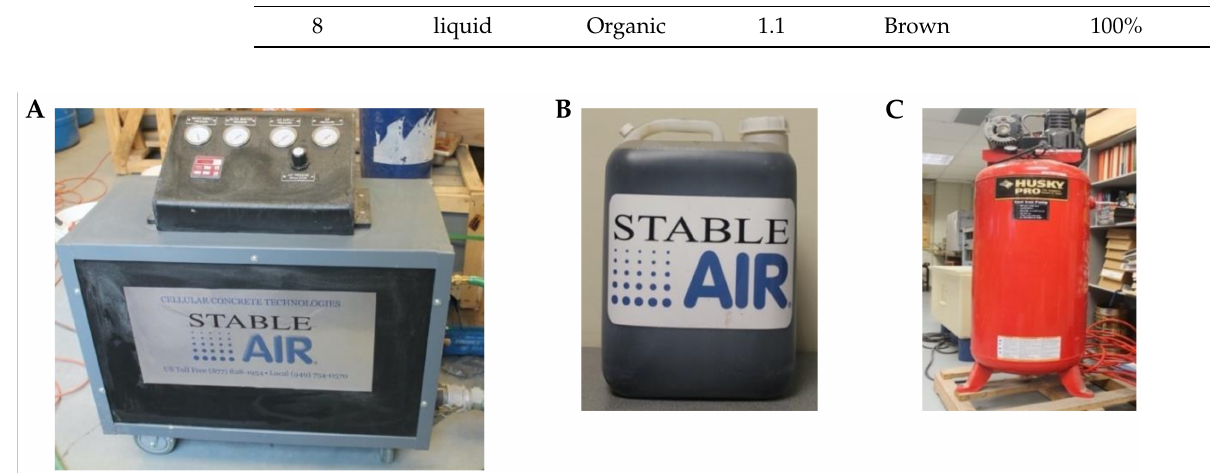
Figure 3. Stable Air®system: ( A ) aerator, ( B ) air-entraining agent, and ( C ) Husky Pro air